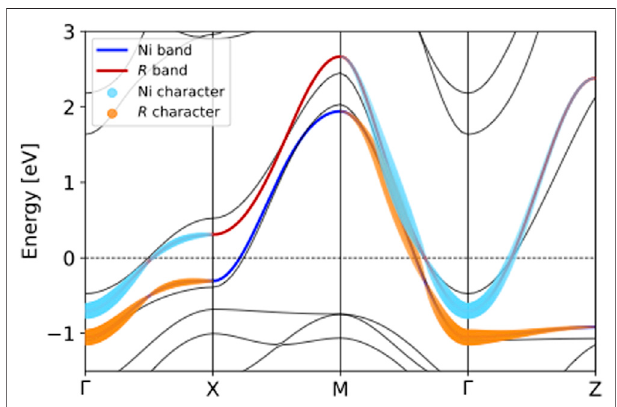
FIGURE 2 | Hybridization of the 2-orbital model for NdNiO 2 , as described in Eq. 4 , showing subdominant Ni and R band character,